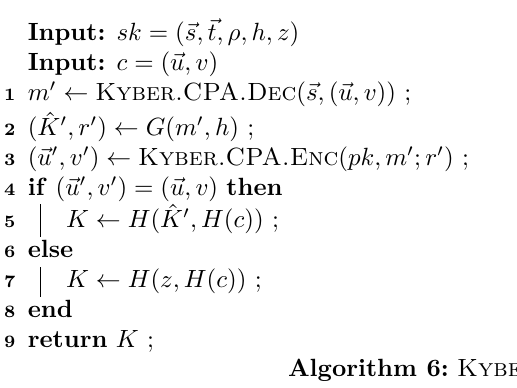
Algorithm 6: Kyber.Decaps